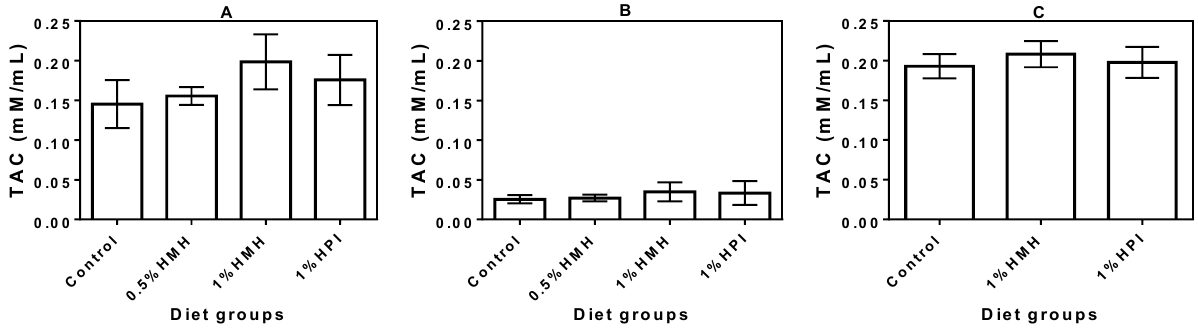
Figure 4. Total antioxidant capacity (TAC) in the plasma of ( A ) young growing spontaneously hypertensive rats (SHRs) (Trial I), ( B ) adult SHRs with established hypertension (Trial II) and ( C ) normotensive rats (trial III) with a casein-only diet or casein diet that contained hemp seed meal protein hydrolysate (HMH) or hemp seed protein isolate (HPI). There were no significant ( p > 0.05) differences between the mean values within each plot. Values are means ( n = 4 rats) ± SD.